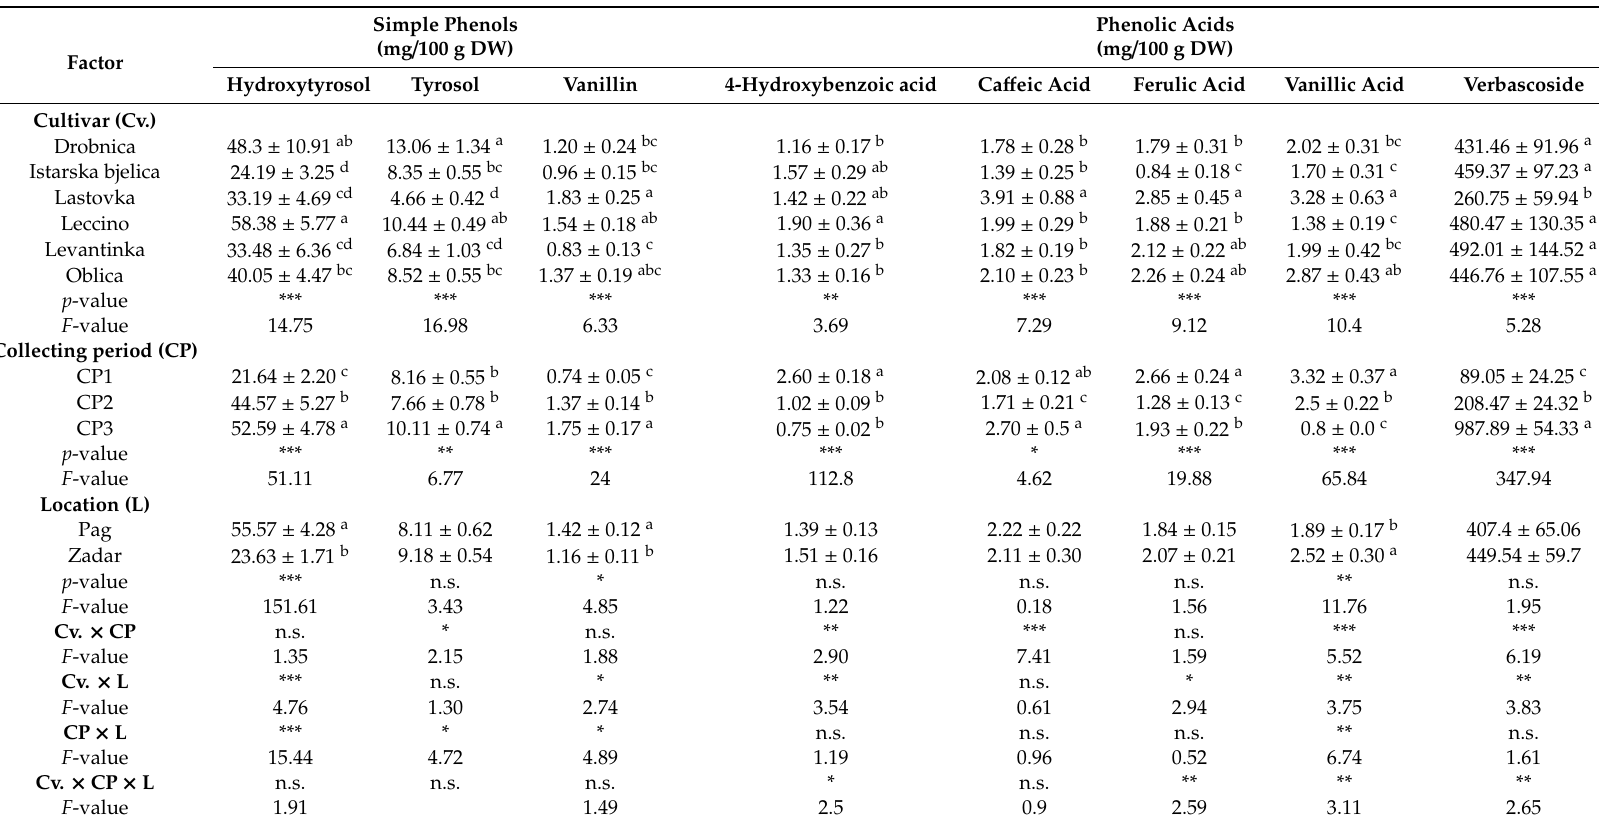
Table 1. Concentrations of simple phenols and phenolic acids (mg / 100 g DW) in leaves of six olive cultivars collected at three di ff erent periods (CP1—October 2017, CP2—January 2018, and CP3—March 2018) in two locations.